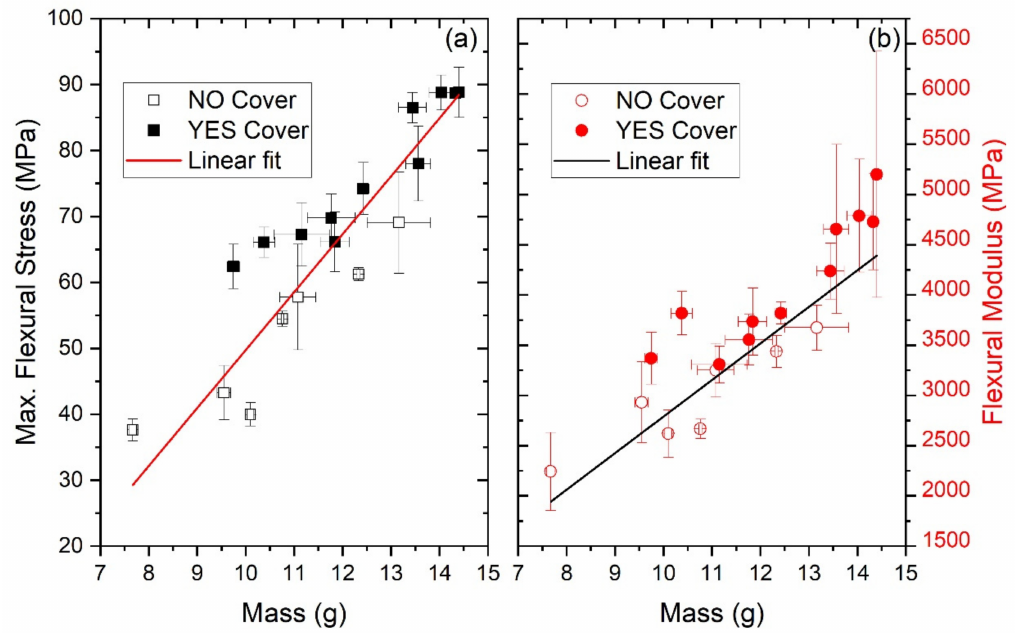
Figure 10. ( a ) Maximum flexural stress and ( b ) flexural modulus as a function of specimen mass for copper specimens with and without